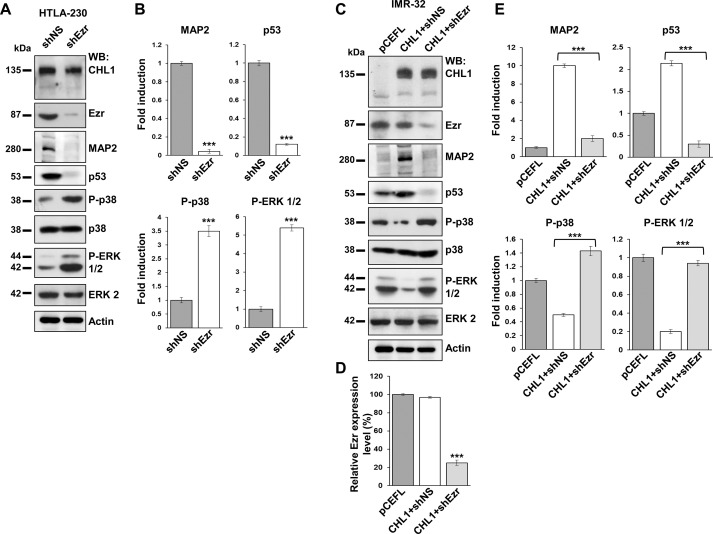
Ezrin silencing in NB cells affected the expression of MAP2, p53, and MAPKs.(A-C) Proteins from HTLA-230 cells transfected with shNS (control) or shEzr and from IMR-32 cells transfected with the empty vector pCEFL (control) or cotransfected with pCEFL-CHL1 and shNS or shEzr, were lysed 7 days after transfection, subjected to Western blot, and probed with anti-CHL1, anti-ezrin, anti-MAP2, anti-p53, anti-phospho-p38 (P-p38), and anti-phospho-ERK 1/2 (P-ERK 1/2) antibodies. (D) 75–80% ezrin expression reduction was achieved in shEzr-IMR-32 cells compared to the non-silenced controls (pCEFL was considered as 100%) with actin used as the loading control. (B-E) Protein levels were quantified by densitometry, normalized to the control values (fold induction = 1) and to the contents of the loading control proteins (actin or total p38 and ERK 1/2), and then visualized by histograms. Data are representative of three independent experiments ± SD. (***p < 0.001).